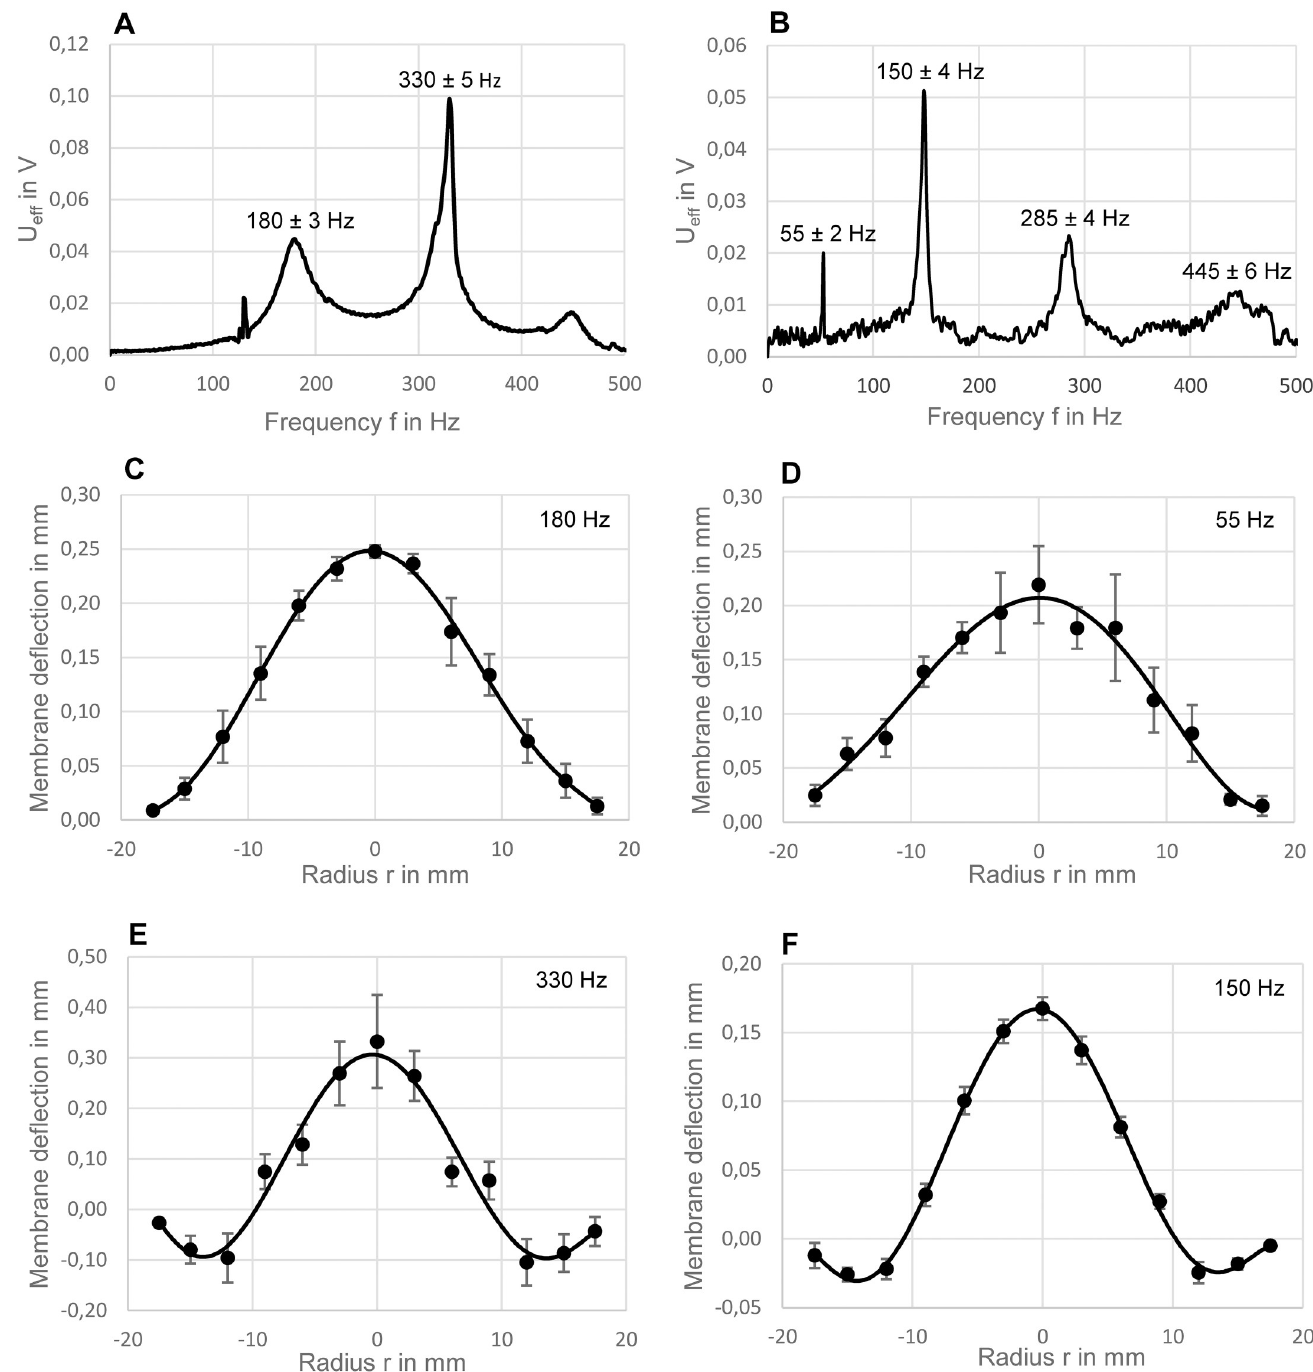
Fig 2. Laser Doppler vibrometry results. Vibration amplitude spectra and corresponding vibration modes recorded without medium in the wells (A, C, E) and with 2.5 ml medium (B, D, F). Frequency spectra (A, B) were plotted for the central position of one membrane. The fundamental modes of the membranes (C, D) (excitation frequency 180 Hz and 55Hz, respectively) and the first harmonic modes of the membranes (E, F) (excitation frequency 330 Hz and 150 Hz, respectively) were averaged values from all 6 membranes of one cell culture plate.